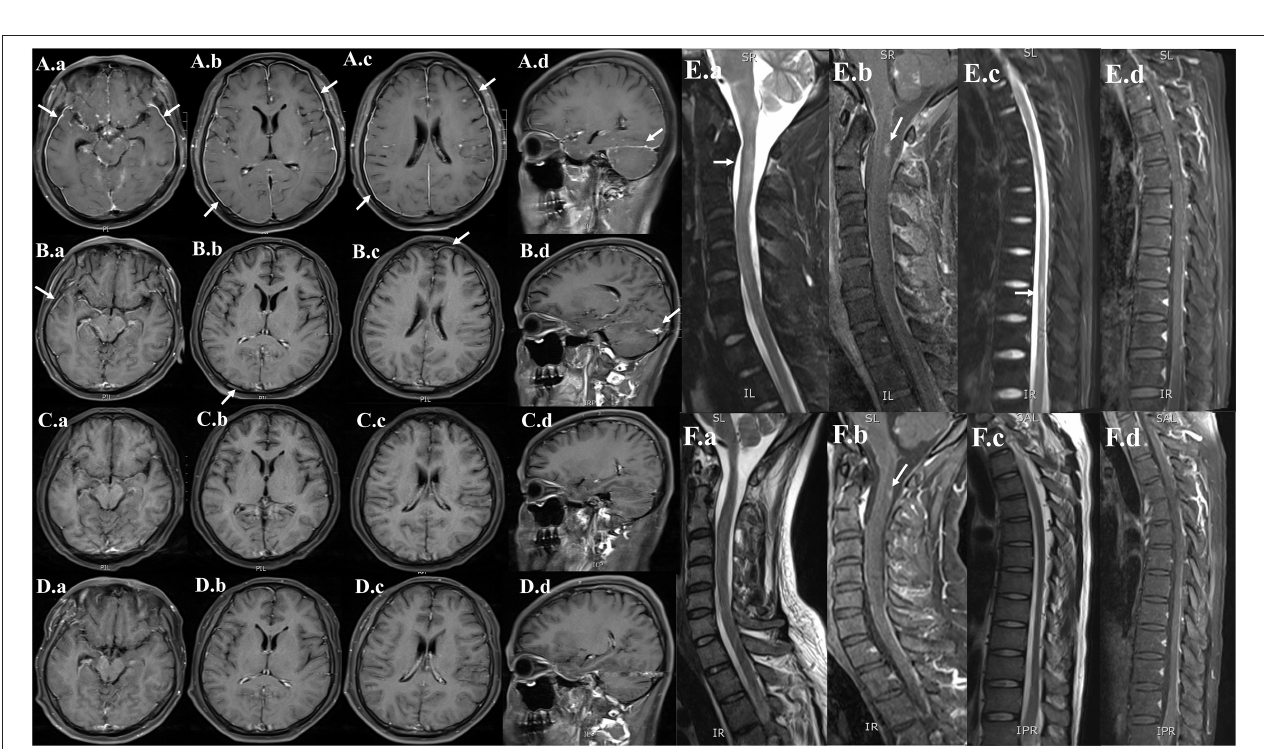
FIGURE 2 | Cerebrospinal fluid (CSF) cytology shows atypical cells. (A) The atypical cells of CSF on day 5 after admission were scattered and varied in size, the cell membrane was malformed, and had a high nuclear-cytoplasmic ratio (black arrows). (B) The CSF cytology on day 19 after admission showed reactive lymphocytes and monocytes. Scale bars: 100 µ m.